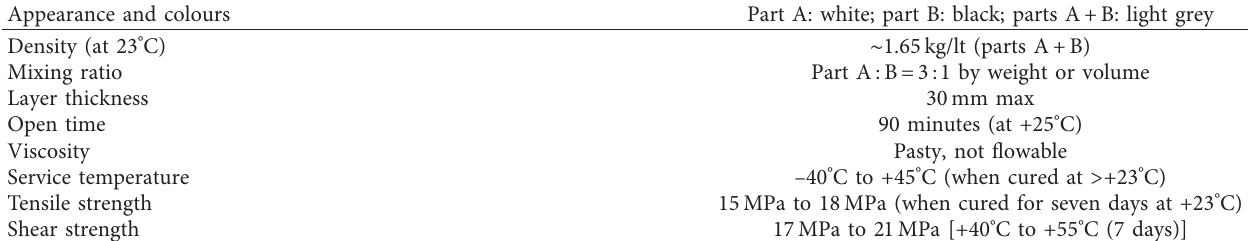
Table 2: Sikadur ® -30 LP (two-part epoxy impregnation resin).